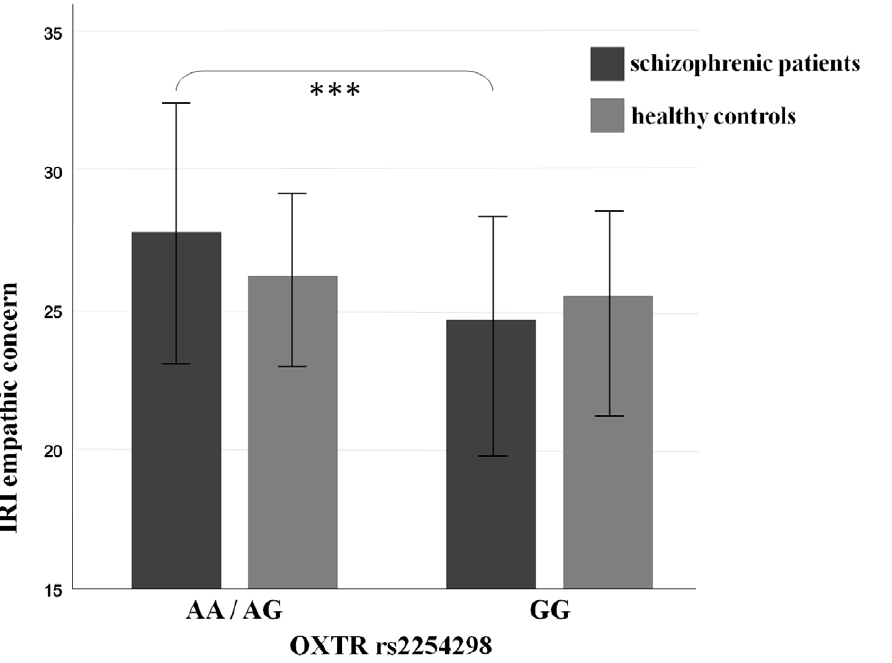
Figure 1. OXTR rs2254298 polymorphisms and IRI ‘empathic concern’ scores in schizophrenic patients and healthy controls. Self- rated IRI ‘empathic concern’ scores are significantly higher in schizophrenic patients endowed with an OXTR SNP rs2254298 AA- or AG-genotype compared to GG-genotype carriers (n=145; mean, SD; t-test for independent samples, ***: p , 0.001), while no significant differences between genotypes are detected in healthy controls (n=145; p . 0.05).